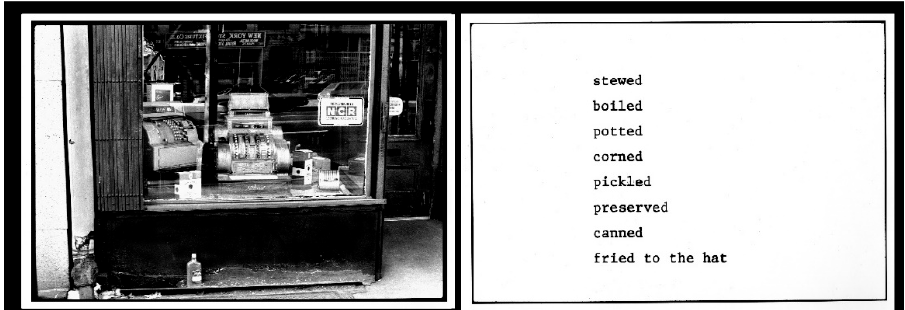
Figure 7. Martha Rosler, from The Bowery in two inadequate descriptive systems , 1974–1975. Two of forty ‐ five gelatin silver prints on board; each diptych panel measures 25.4 cm × 55.9 cm. © Martha Rosler/Courtesy of the artist and Mitchell ‐ Innes & Nash, New York.